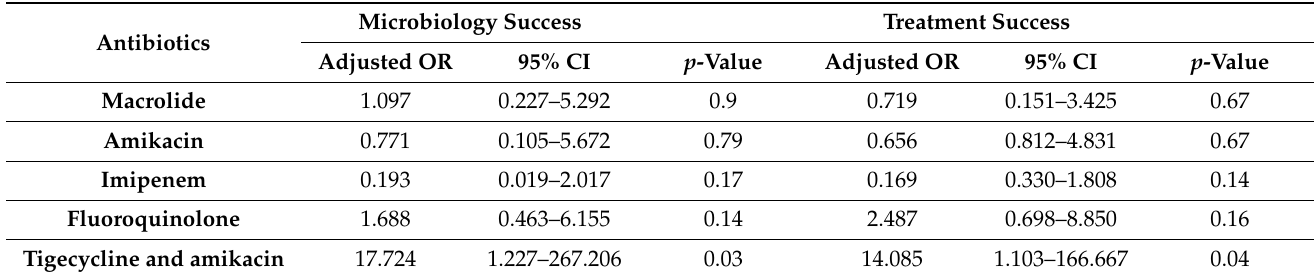
Table 4. Multivariable analysis for treatment outcomes according to Individual